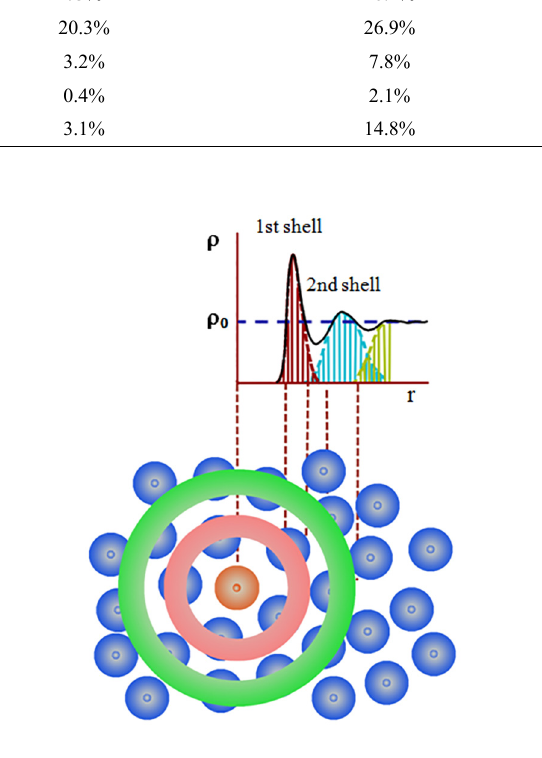
Figure 2. The illustration of pair distribution function. 56